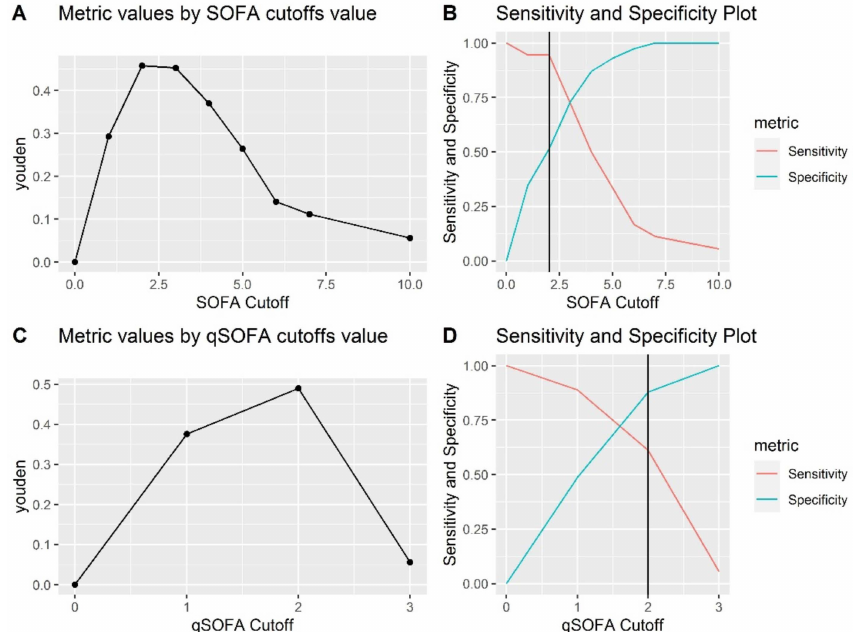
Figure 2. Establishment of risk score cut-off values. ( A ) Youden index according to SOFA cutoffs; ( B ) sensitivity and specificity according to SOFA cutoffs; ( C ) Youden index according to qSOFA cutoffs; ( D ) sensitivity and specificity according to qSOFA cutoffs.